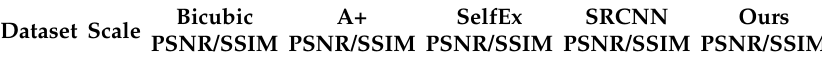
Figure 16. Image “ppt3” (Set14, × 3): there are sharper edges between “H”, “o” and “w” in our result; while in other works, the text is blurry. SR, Super-Resolution. Table 7. Quantitative evaluation of state-of-the-art SR methods. We evaluated average PSNR/SSIM for scale factors × 2, × 3 and × 4 on datasets Set5,